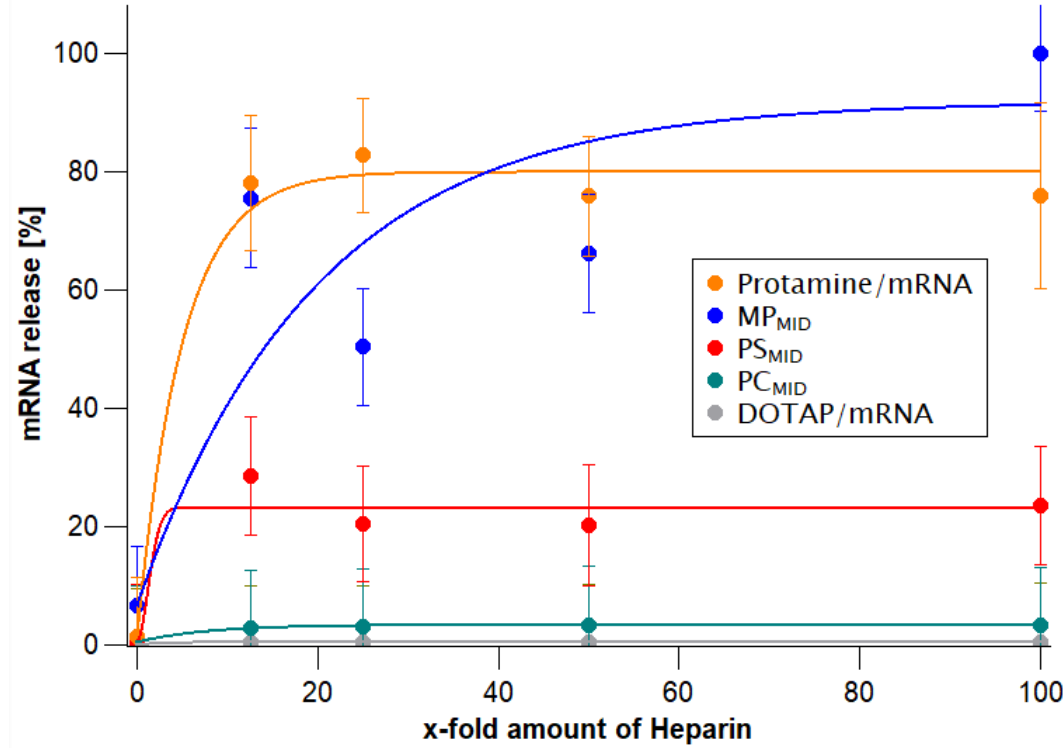
Figure 2. Release of mRNA after the addition of heparin in H 2 O, tested at an N/P ratio of 2 for protamine/mRNA particles (orange), DOTAP/mRNA particles (grey), MP MID (blue), PC MID (green), and PS MID (red) particles. The curves are drawn to guide the eye.